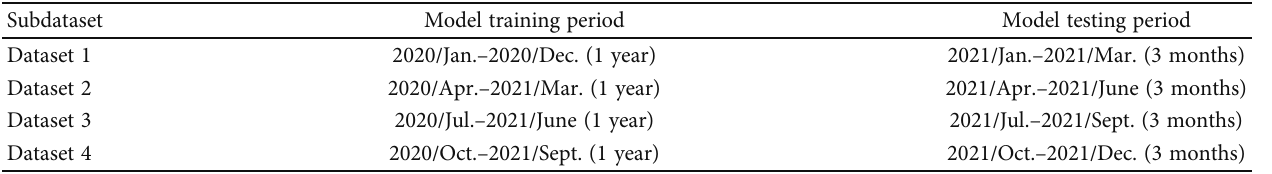
Table 3: The four subdatasets for model training and model